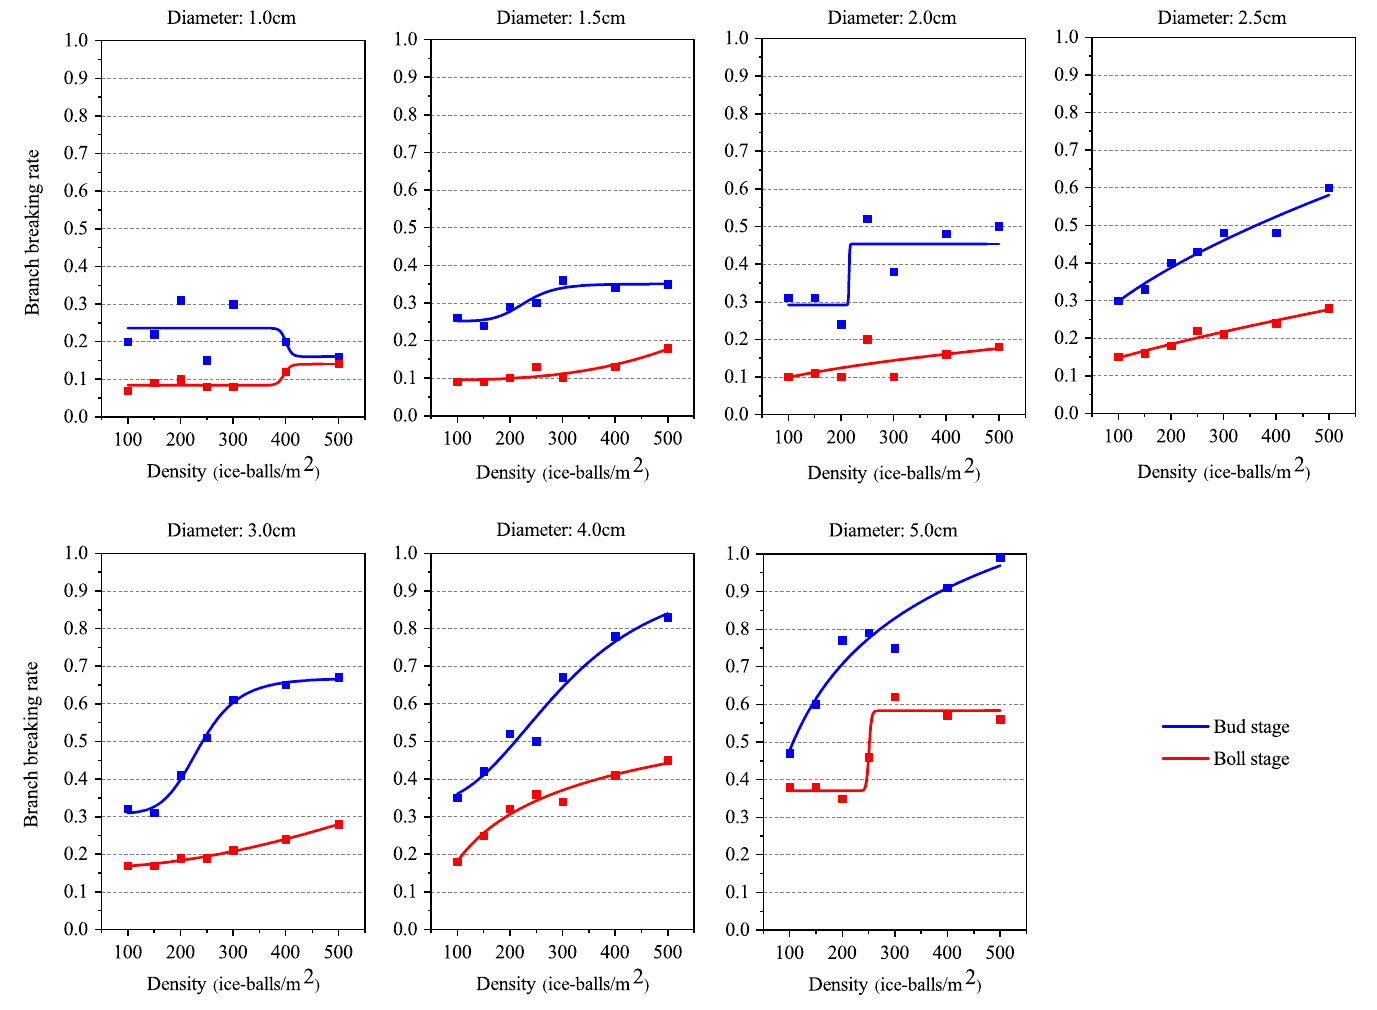
Fig 5. Logistic function between the branch injury rate and hail fall density.